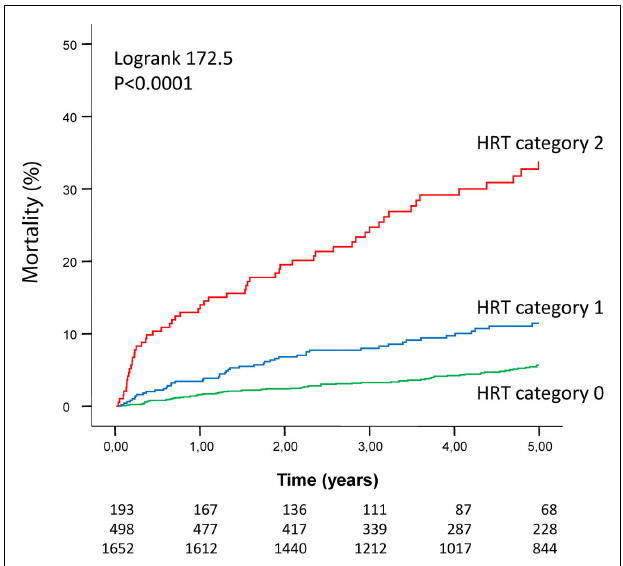
FIGURE 2 | Risk stratification by heart rate turbulence in the ISAR-RISK study (Bauer et al., 2009a). The number of patients of the individual groups involved in the analyses at 0, 1, 2, 3, 4, and 5years are shown under the graphs.The top and the bottom row corresponds to the upper and bottom Kaplan–Meier curve respectively. For all three comparisons (HRT category 0 vs. HRT category 1, HRT category 0 vs. HRT category 2, and HRT category 1 vs. HRT category 2) the p -value was < 0.0001. (Adapted by permission from Bauer et al.,